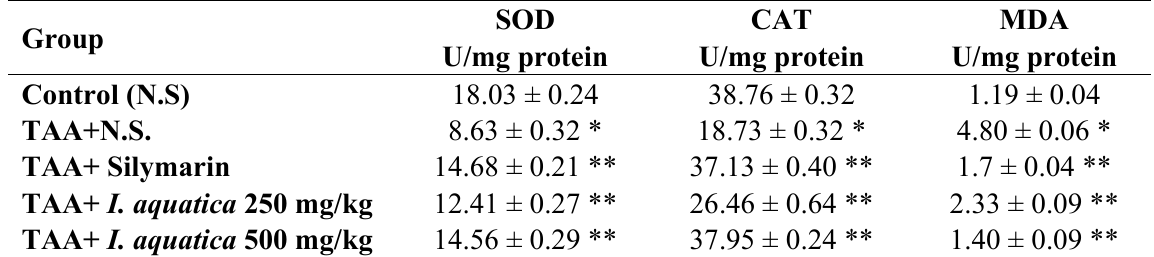
SOD CAT U/mg protein U/mg protein